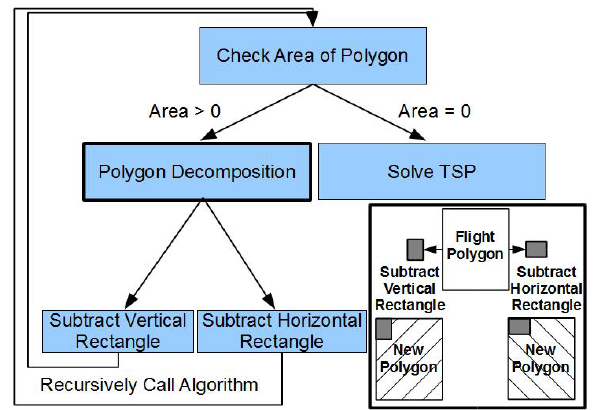
Figure 6: Flowchart of path planning algorithm - inset contains visual of polygon decomposition process